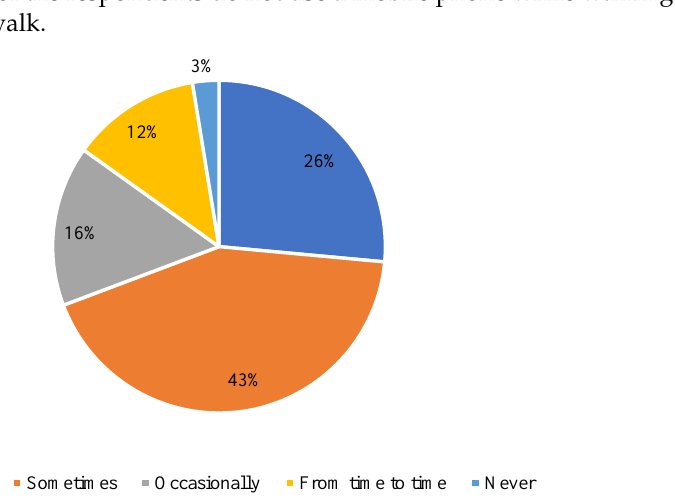
Figure 3. Characteristics of the respondents in terms of the frequency of using a mobile phone while walking on the street or on the sidewalk.